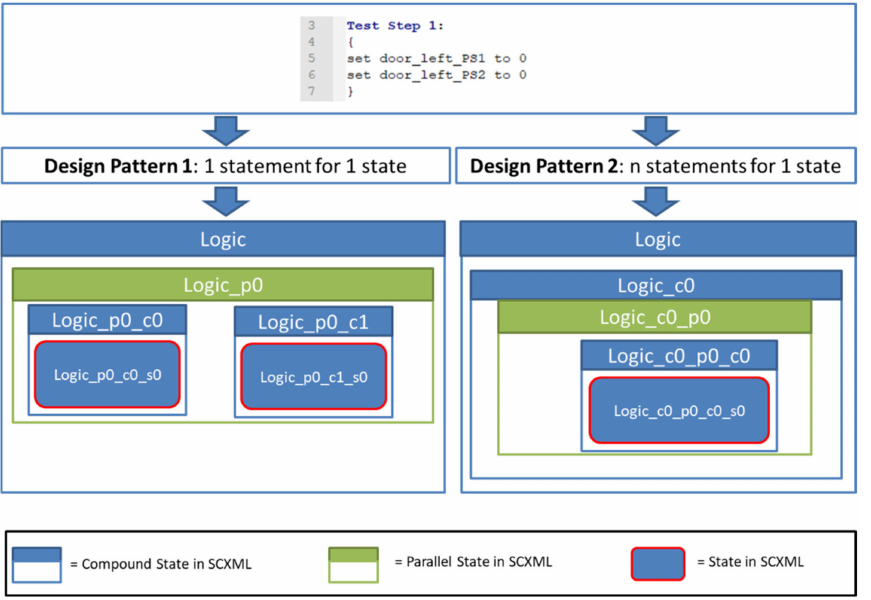
Figure 8. Example of different design patterns for the same test case in